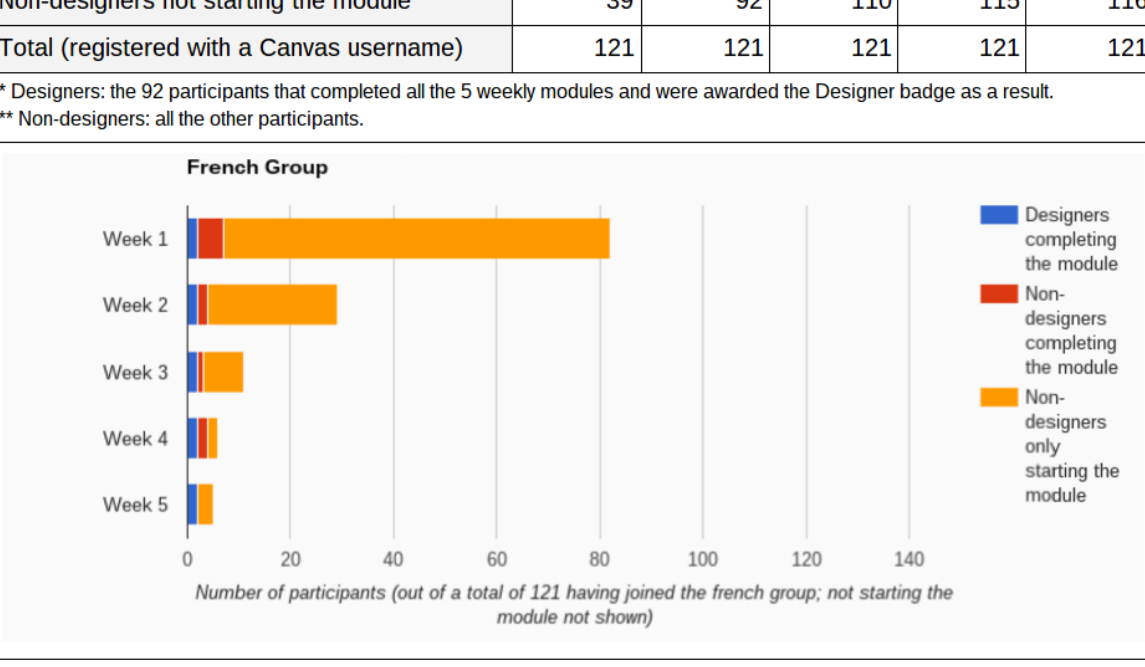
Figure 6 . French group: Participation in weekly modules of